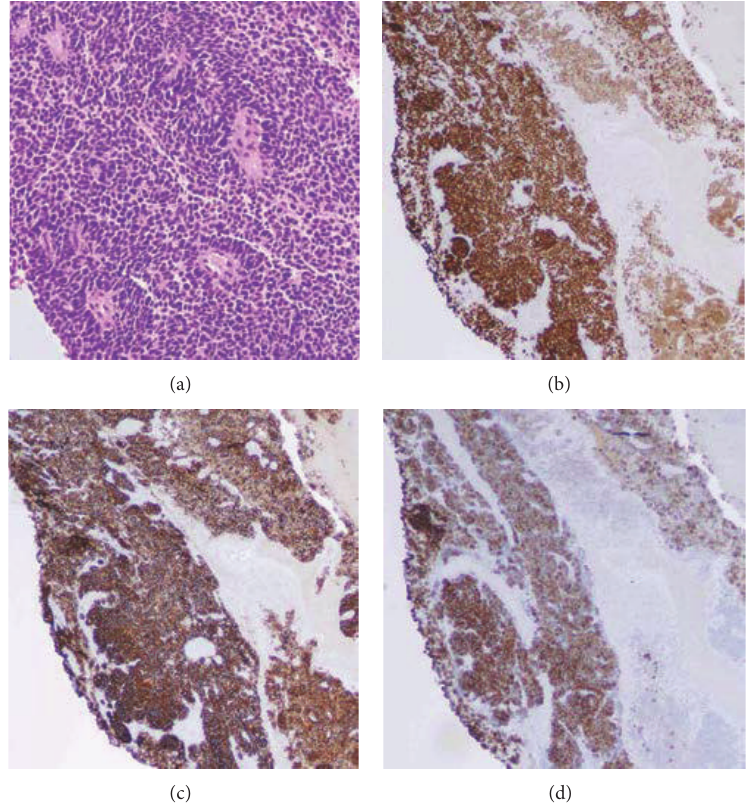
Figure 6: Histologic and immunohistochemical features of tumor in the left cerebellum. (a) Microscopic photographs from left cerebellar resection show sheets of primitive tumor cells with neuroblastic rosettes resembling a primary medulloblastoma. The tumor cells demonstrate immunohistochemical reactivity for (b) myogenin, (c) CD56, and (d) tyrosine-hydroxylase to show both myogenic and neural differentiation (original magnification × 200 (a–d)).